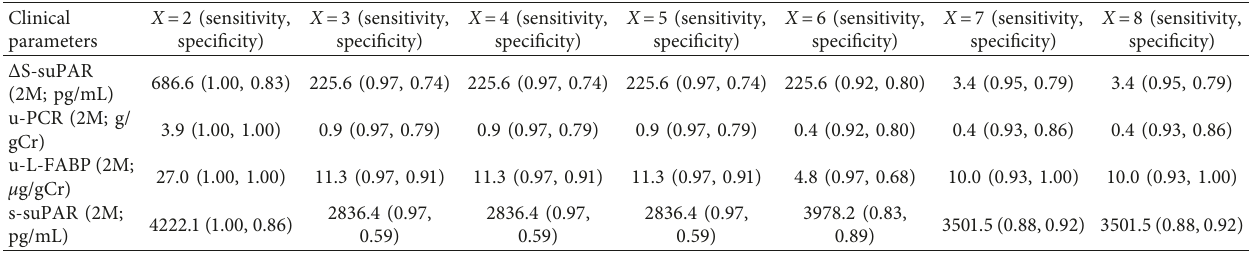
Table 3: Optimal cutoff values of predictive parameters for the CI of 40% reduction in the eGFR by X years after the initiation of IST.